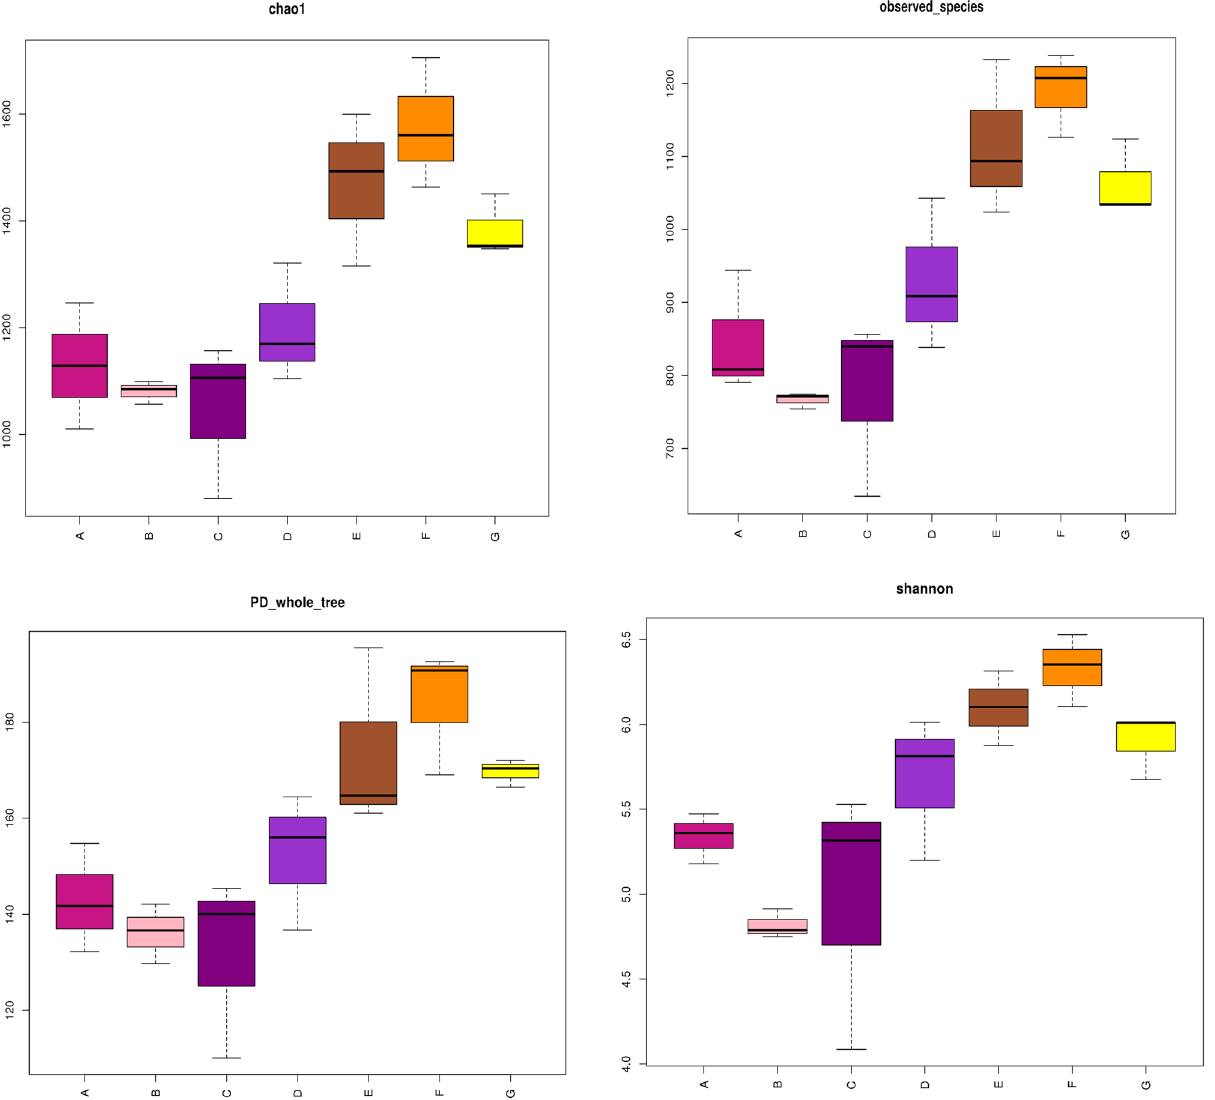
Figure 1. Chao1, observed-species, PD_whole_tree, and Shannon index of fungi of different continuous cropping year. Uppercase of A, B, C, D, E, F and G represent 5,10,15, 20, 25, 30 years, and 30 years with stubble cropping,